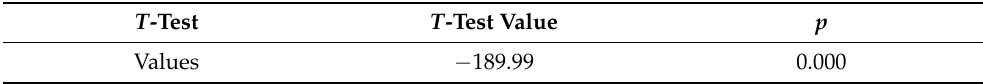
Table 3. T -test values. There were statistically significant differences between the two electrodes. The values recorded with the periodontal electrode were higher than those of the combined electrode. T -Test T -Test Value p Values − 189.99